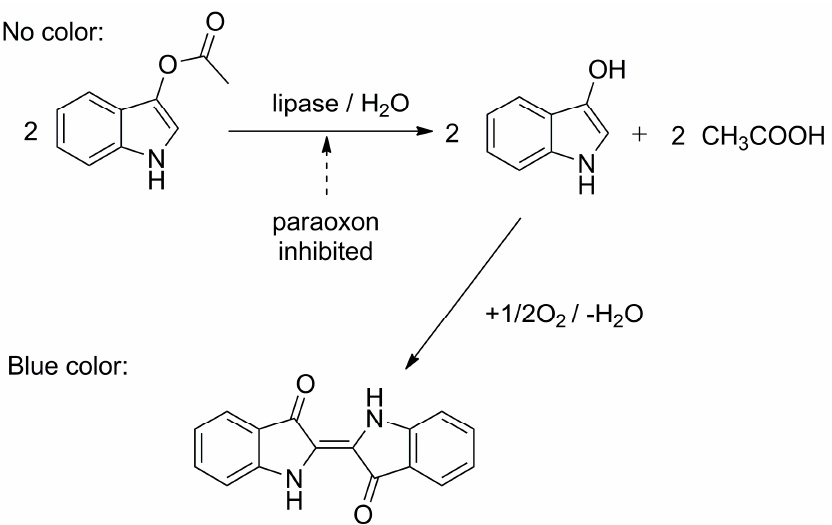
Figure 6. The principle of the colorimetric assay based on indoxyl acetate hydrolysis by lipase which can be inhibited by pesticides like paraoxon.